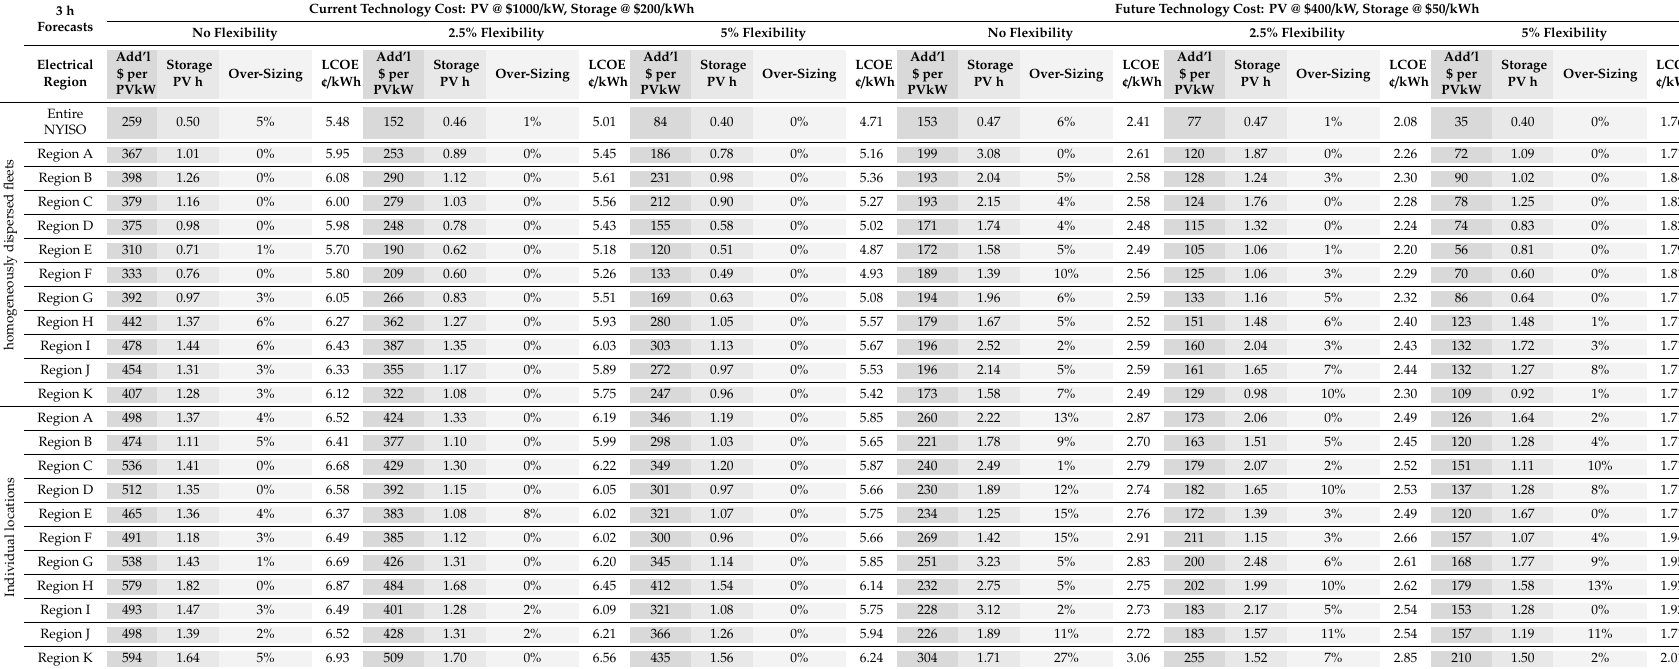
Table 2. Three-hours-ahead